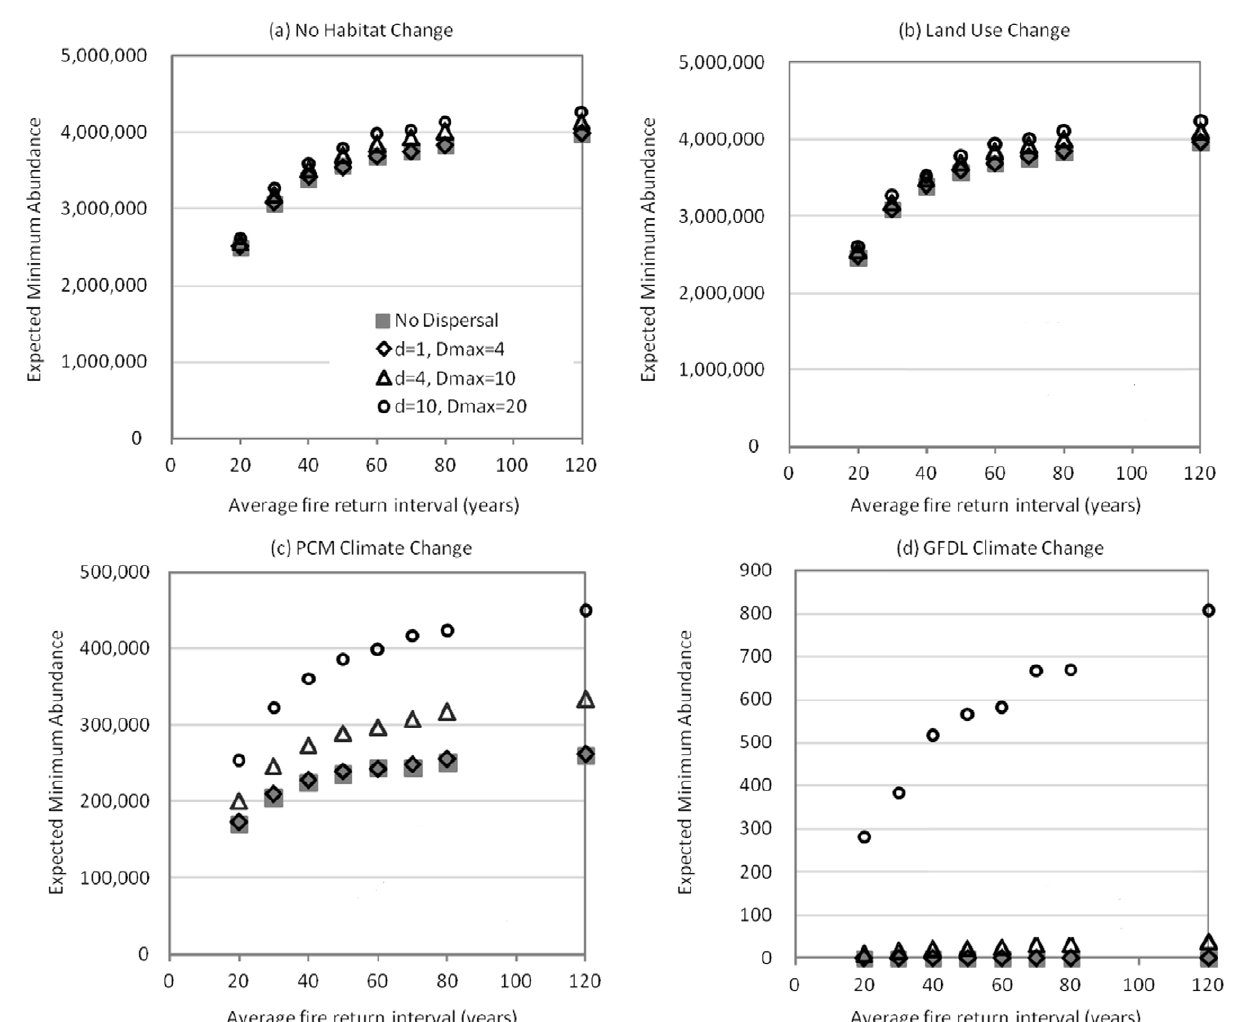
Figure 3. Expected minimum abundance for various dispersal, fire and habitat change scenarios. The four panels correspond to four climate and land use scenarios: (a) no habitat change, (b) land use change, (c) PCM climate change, and (d) GFDL climate change. Dispersal parameters are shown in (a) in km. The settings for the average and maximum dispersal distances d =1 and D max =4 represent upper limits of empirically observed dispersal distances by jays. Throughout, the dispersal flow parameter is a =0.01. Note the change in vertical axis units across graphs. No error bars are included because they would be smaller than the symbols on the figure. The mean of 1,000 model runs varies by less than 1% between different 1,000-run